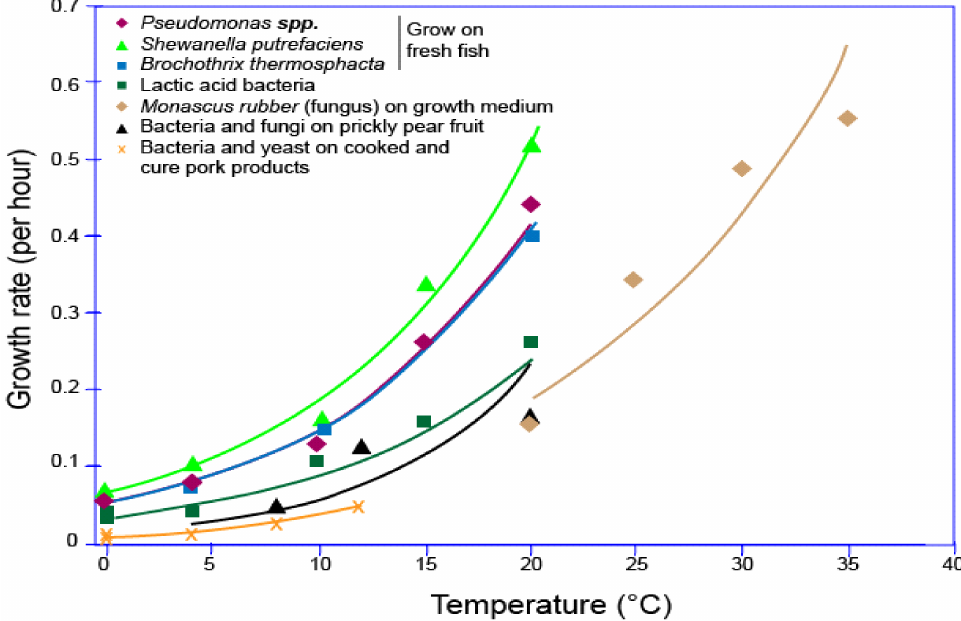
Figure 2. Growth rate of various types of microbes depending on the time. Modified from